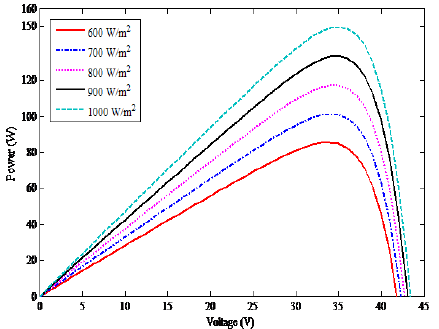
Fig. 3: P-V characteristics under variable irradiation.